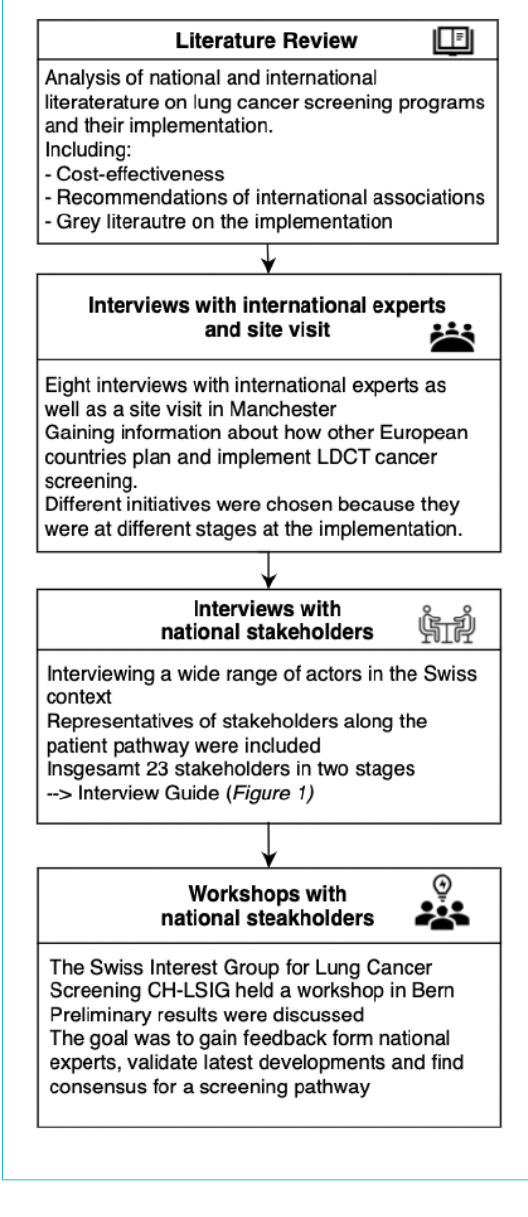
Figure 1: Framework for a country specific screening